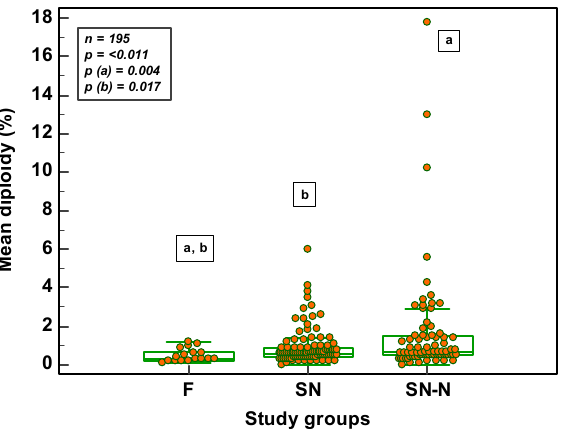
Figure 6. Frequency of mean sperm diploidy in the different study groups (F = fertile population; SN = subfertile population with normozoospermia; SN-N = subfertile non-normozoospermic population). The frequencies of sperm nullisomy, disomy and diploidy were considered when alteration was above the upper limit of normality of the F group. In short, for chromosome 13, the upper values for nullisomy and disomy were 0.6% and 0.4%; for chromosome 18, 0.3% and 0.7%; and for chromosome 21, 0.4% and 0.2%, respectively. For sex chromosome nullisomy the upper value was 1.2% and the disomy was 0.8% (XX), 0.4% (XY) and 0.3% (YY). Autosomal aneuploidy and diploidy had an upper limit of 1.3% and sex chromosome aneuploidy was 1.6%. Figure 7 shows the frequency and percentages of aneuploidy in the SN and SN-N study groups. A total of 47.3% (96/203) had aneuploidy in the subfertile groups; 49 in the SN (41.9%) and 47 (54.7%) in the SN-N ( p = 0.0718) groups, respectively. Irrespective of the semen quality, genetic alterations were equally distributed in the SN and SN-N groups except for disomy which was significantly 3-fold higher in the SN-N as compared to the SN